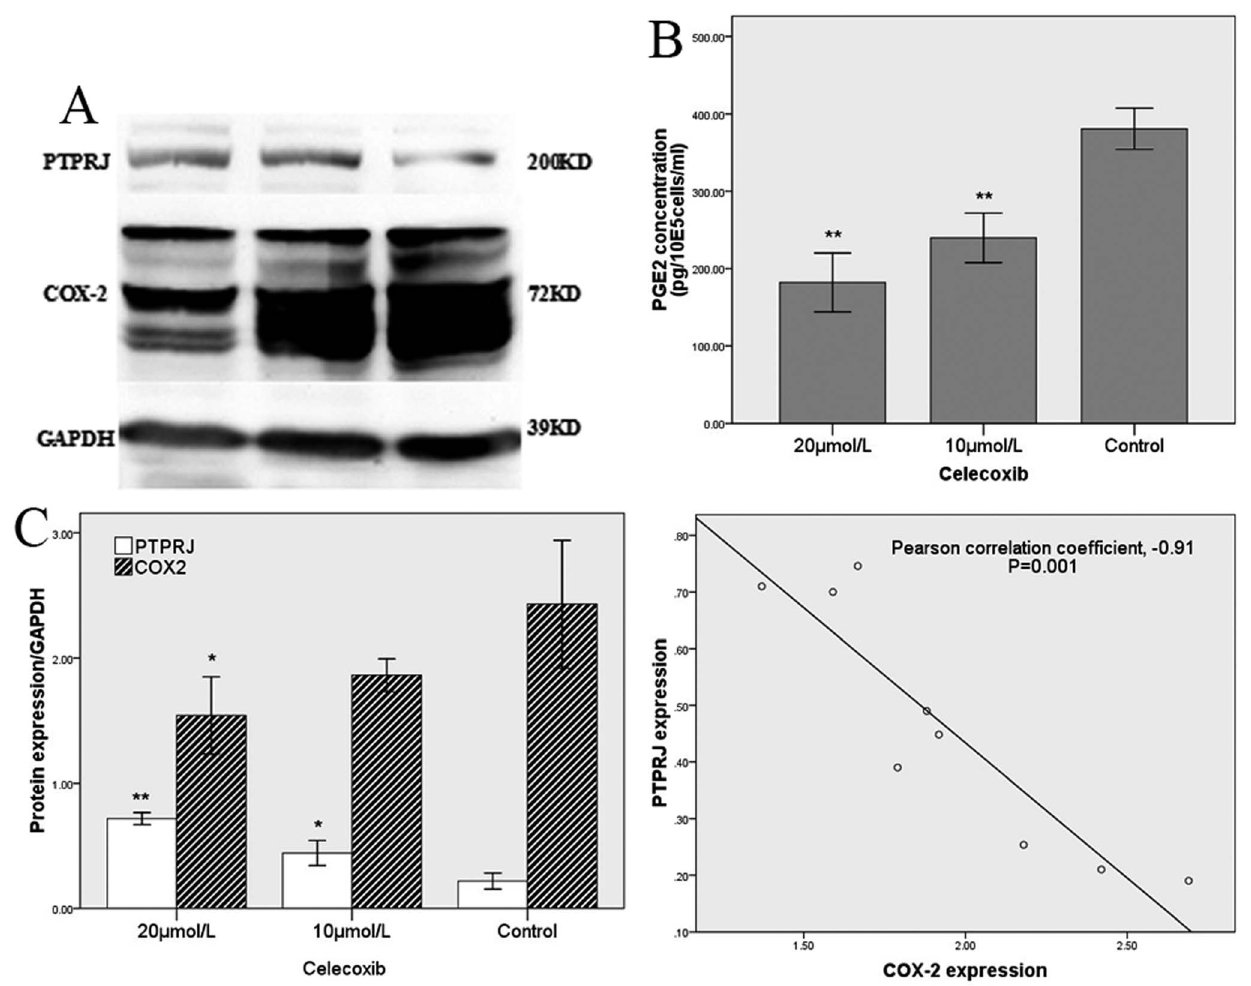
Fig. 5. PTPRJ expression is rescsued by the COX-2 selective inhibitor Celecoxib. (A) Western blot analysis of PTPRJ and COX-2 in protein extracts from HUVEC cells stably over-expressing COX-2 and treated for 24 h with 20 m M or 10 m M Celecoxib. Expression is normalized to GAPDH. Relative levels of PTPRJ were quantified using Image J. (B) ELISA quantification of PGE 2 in HUVEC supernatant; data is expressed as concentration of PGE 2 . ** P , 0.01 compared to the 0.1% DMSO-treated control group. (C) Relative COX-2 and PTPRJ expression in HUVEC cells treated with varying concentrations of Celecoxib. Expression is normalized to GAPDH. Relative levels of COX-2 and PTPRJ were quantified using Image J. *P ,